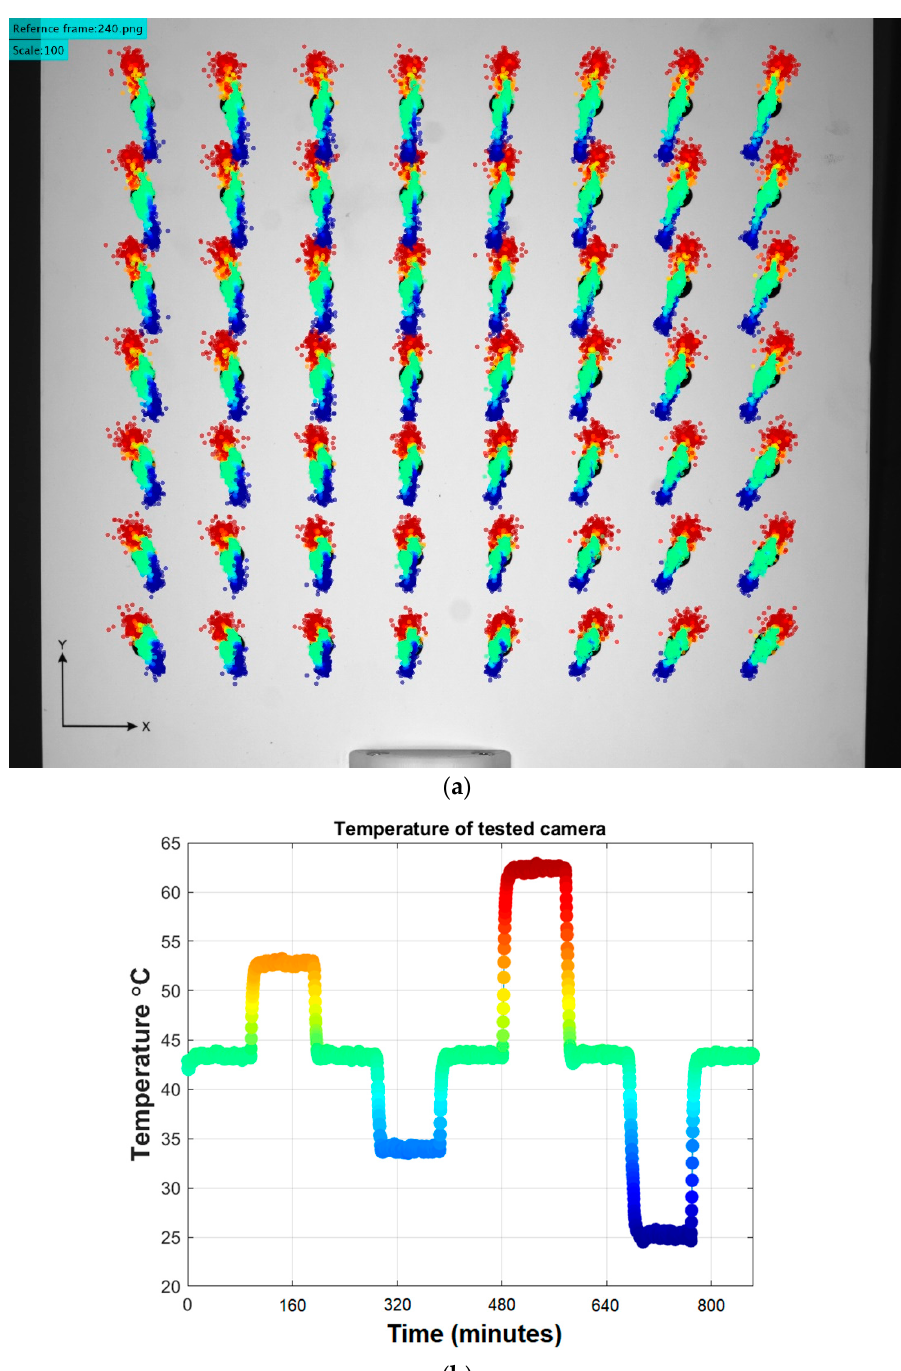
Figure 1. ( a ) Example of a registered thermal image drift with respect to the initial positions of 56 markers forming arrays. All marker trajectories are scaled ×100 for better visualization. The color of each marker represents the temperature of the camera during its frame capture. ( b ) Plot representing the temperature values of the camera during each frame capture. The color scale is consistent with the drifts shown in ( a ).